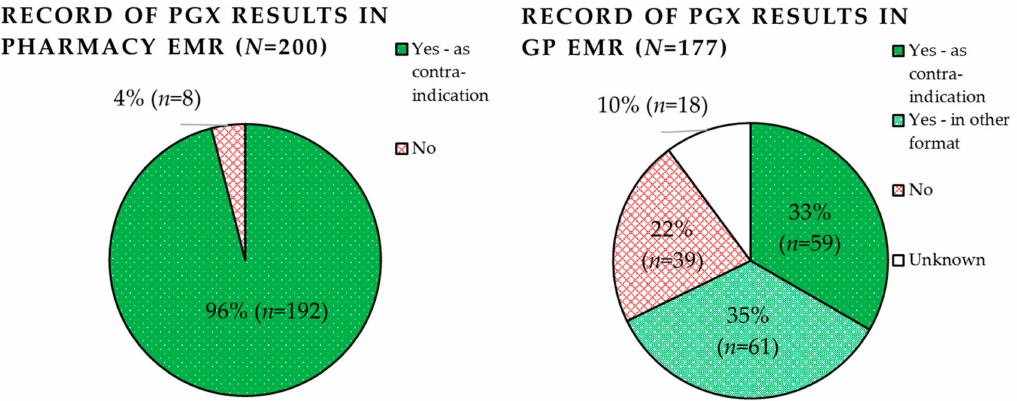
Figure 3. Record of pharmacogenetic panel results in the pharmacy and general practitioner (GP) electronic medical records